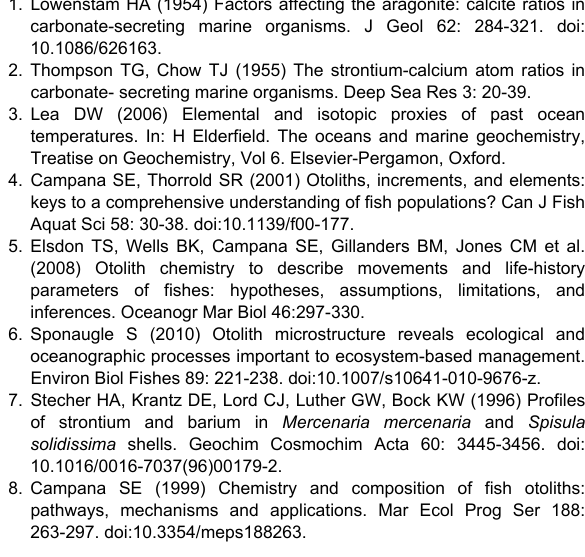
Table S1. Correlations (r) between partition coefficients (D ) and somatic growth rates and vertebral precipitation Me rates for the temperature (T) experiment. The number (n) of round rays ( Urobatis halleri ) included in growth rate estimates, observed range of individual somatic growth rates (mm disc width month -1 ), and vertebral precipitation rates (μm radius month -1 ) are reported for each treatment. No significant correlations were detected (p ≥ 0.12).